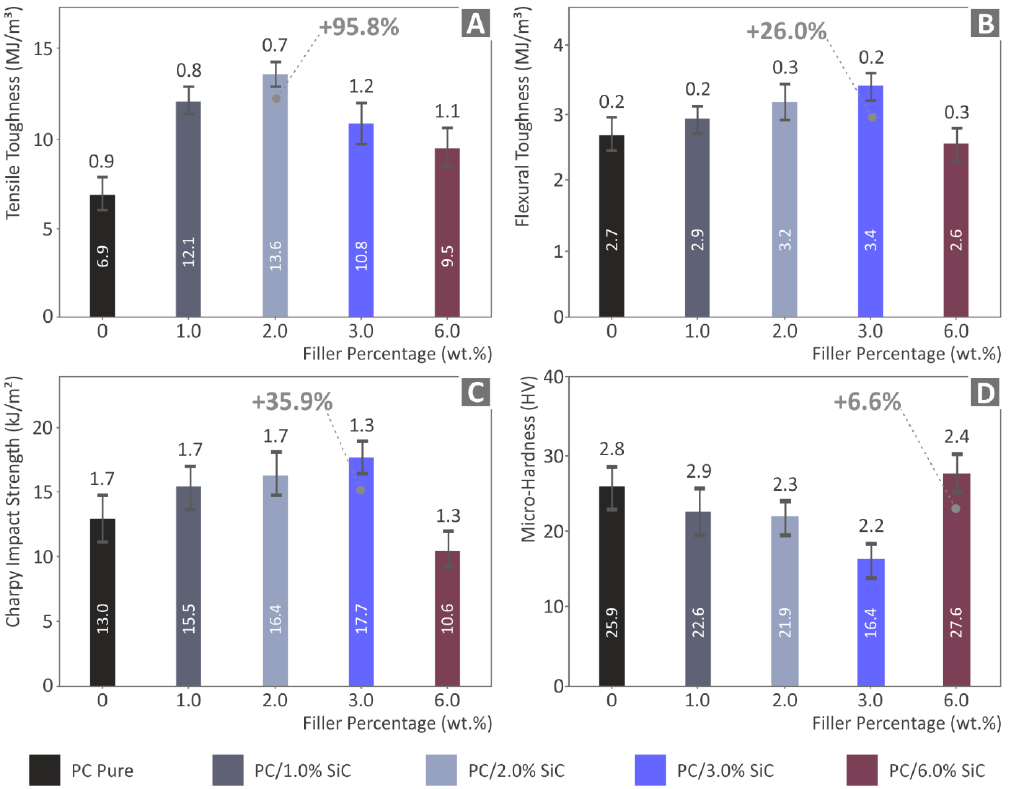
Figure 7. ( A ) Mean calculated tensile toughness (MJ/m 3 ) and the corresponding calculated deviation of the five samples tested, ( B ) mean calculated flexural toughness (MJ/m 3 ) and the corresponding calculated deviation of the five samples tested, ( C ) experimentally calculated impact strength (kJ/m 2 ) and the corresponding calculated deviation of the five samples tested, and ( D ) measurements of the Vickers microhardness and the corresponding calculated deviation of the five samples tested.